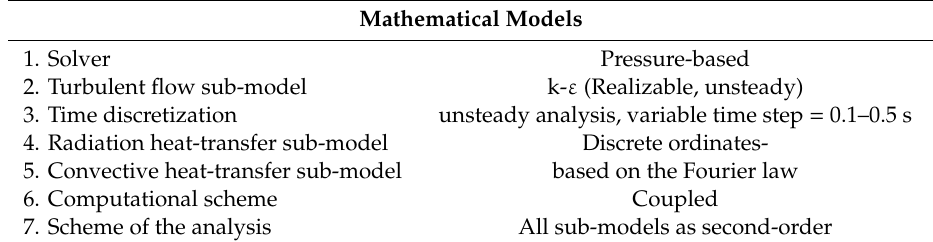
Summary of the user-defined solver settings in the computational fluid dynamics (CFD)